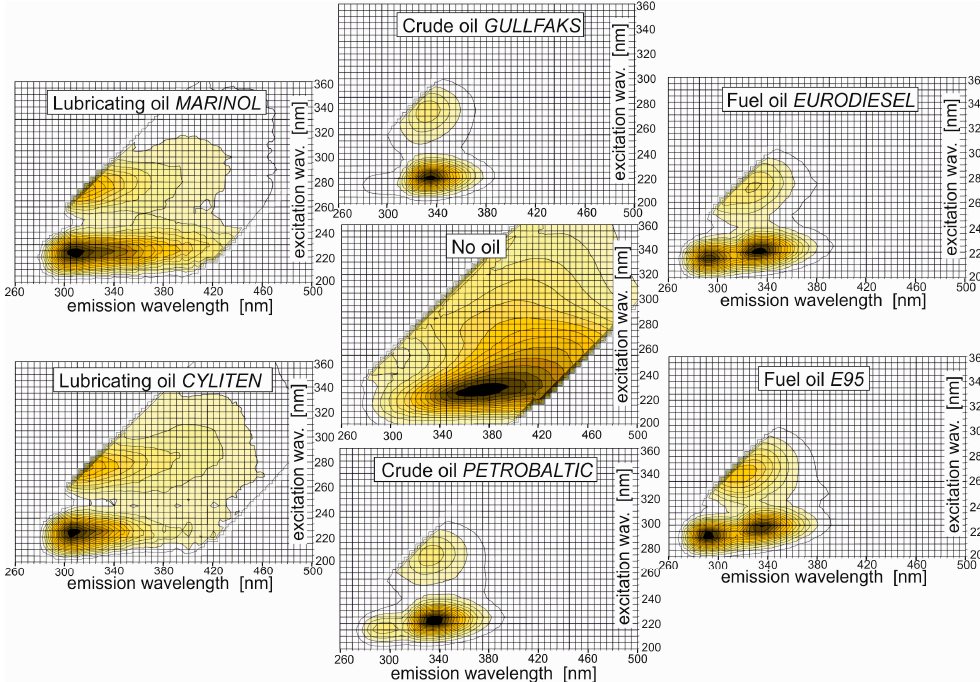
Figure 2. Excitation–emission matrix (EEM) spectra of seawater sampled on March 15, 2019, and the same seawater artificially polluted by individual oils for an oil-to-water ratio of 50 × 10 -6 . Each spectrum is normalized to its maximal peak.